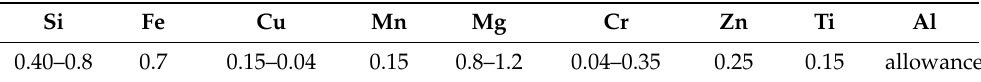
Table 1. Chemical composition (wt%) of 6061-T6 Al alloy.